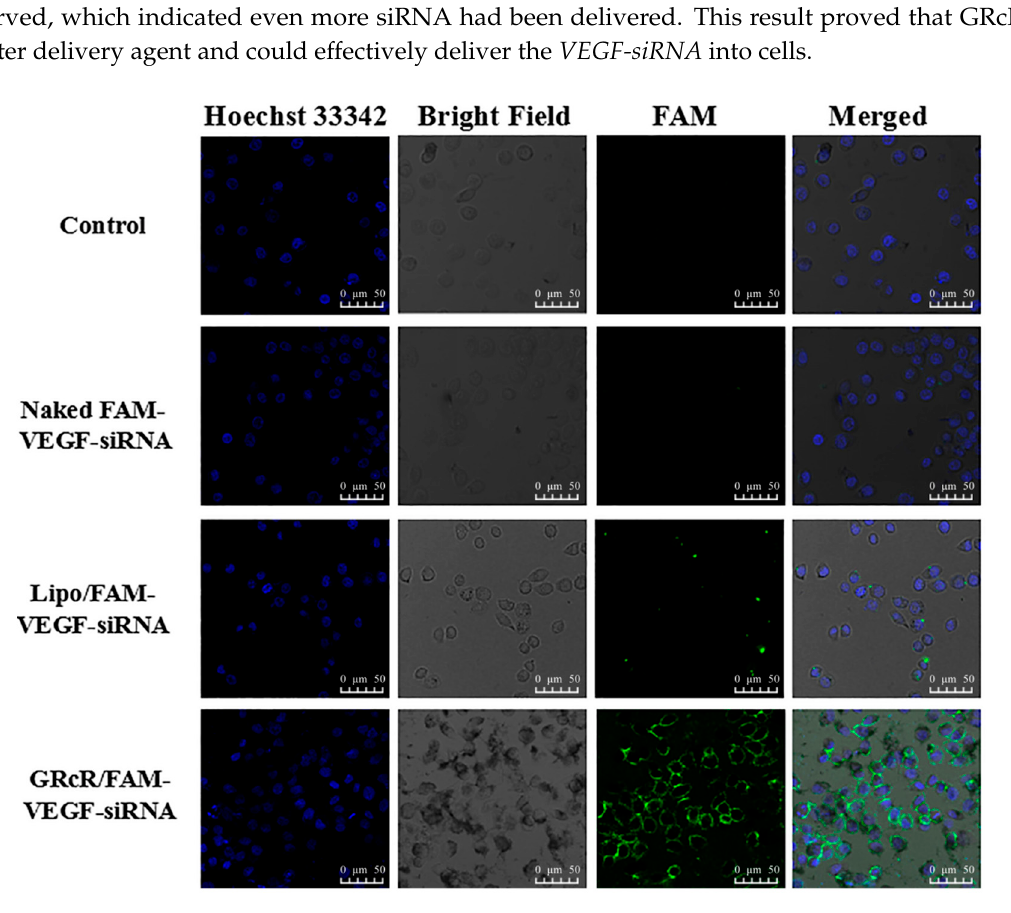
Figure 10. MTT assay for GRcR at different concentrations of HeLa cells, the data was presented as the mean ± SD, n = 3.